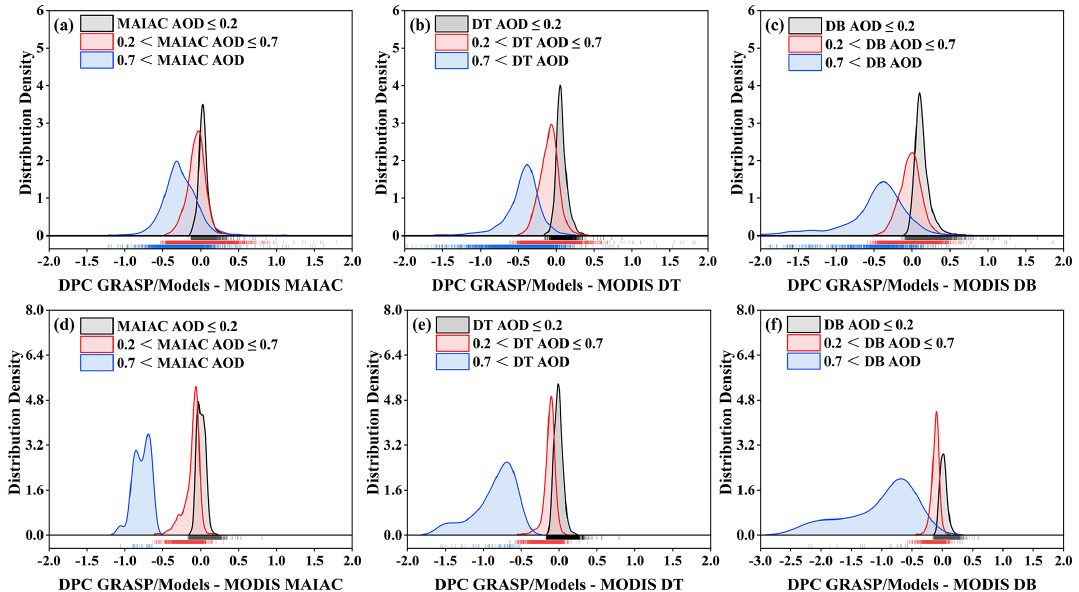
Figure 7. Distribution density of AOD differences between the DPC GRASP/Model scheme and MODIS DT, DB, and MAIAC products for (a–c) eastern and southern China with its adjacent sea areas and (d–e) areas of western Europe including the Atlantic Ocean and the Mediterranean Sea. It is noted that the MODIS DB product only releases terrestrial AOD